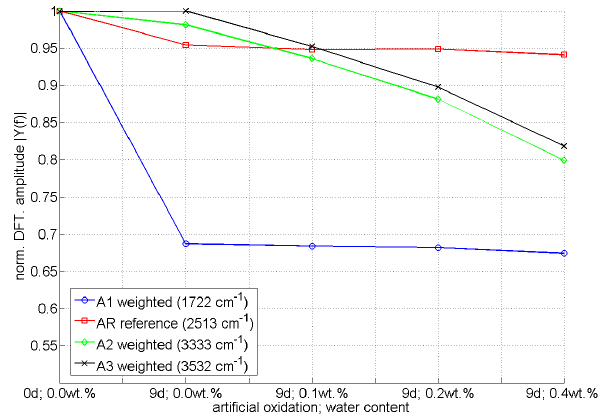
Figure 10. Comparison of aged synthetic motor oil (9 days) with water contaminations of 0, 0.1, 0.2, 0.4wt.%, respectively, mea- sured with a detector in mineral oil configuration (reference